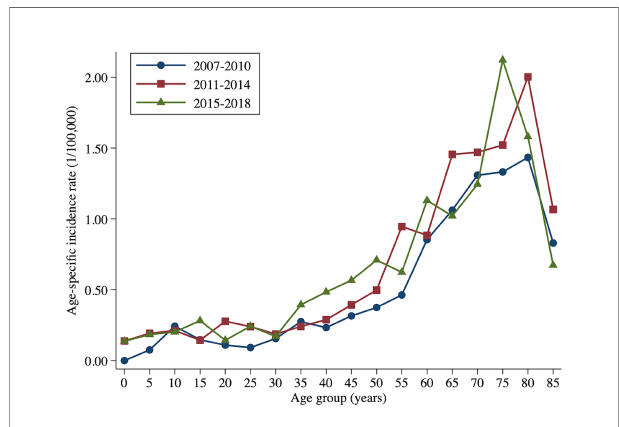
FIGURE 3 | Age-speci fi c incidence rate of peripheral T-cell lymphoma in